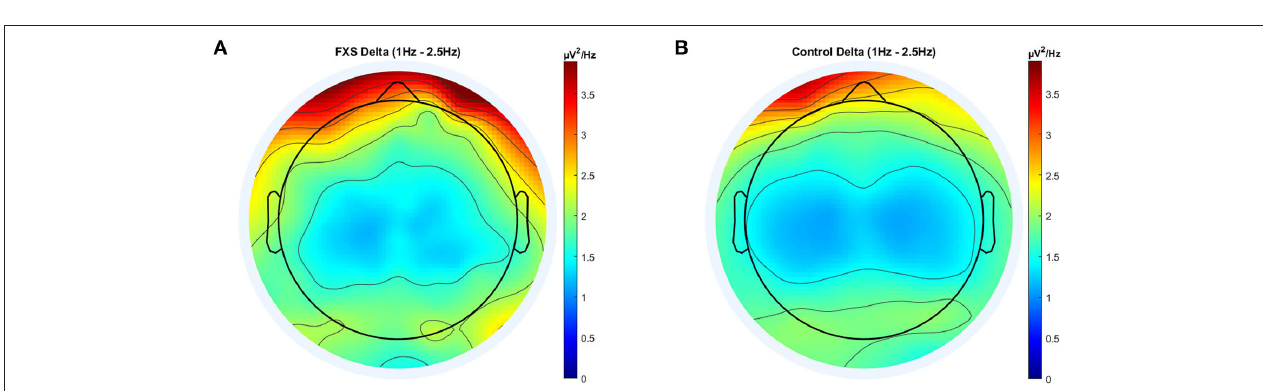
FIGURE 2 | Topographic representation of average power spectral density in the FXS (A) and control (B) group for the delta band (1–2.5Hz).